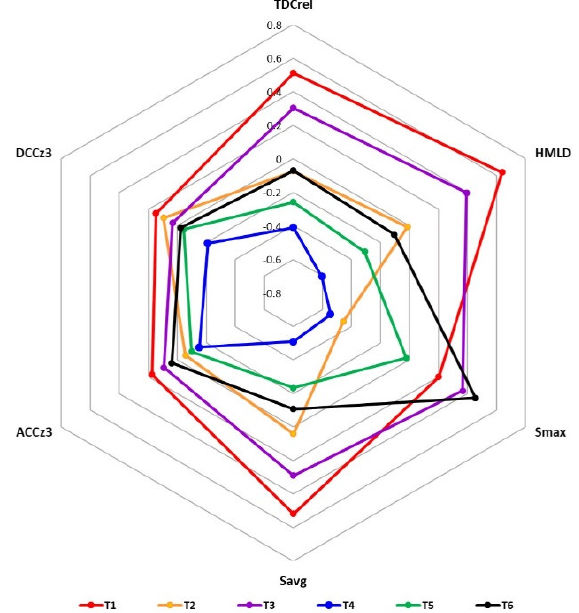
Figure 1. Comparison of selected external load parameters within different match timing zones. Note: